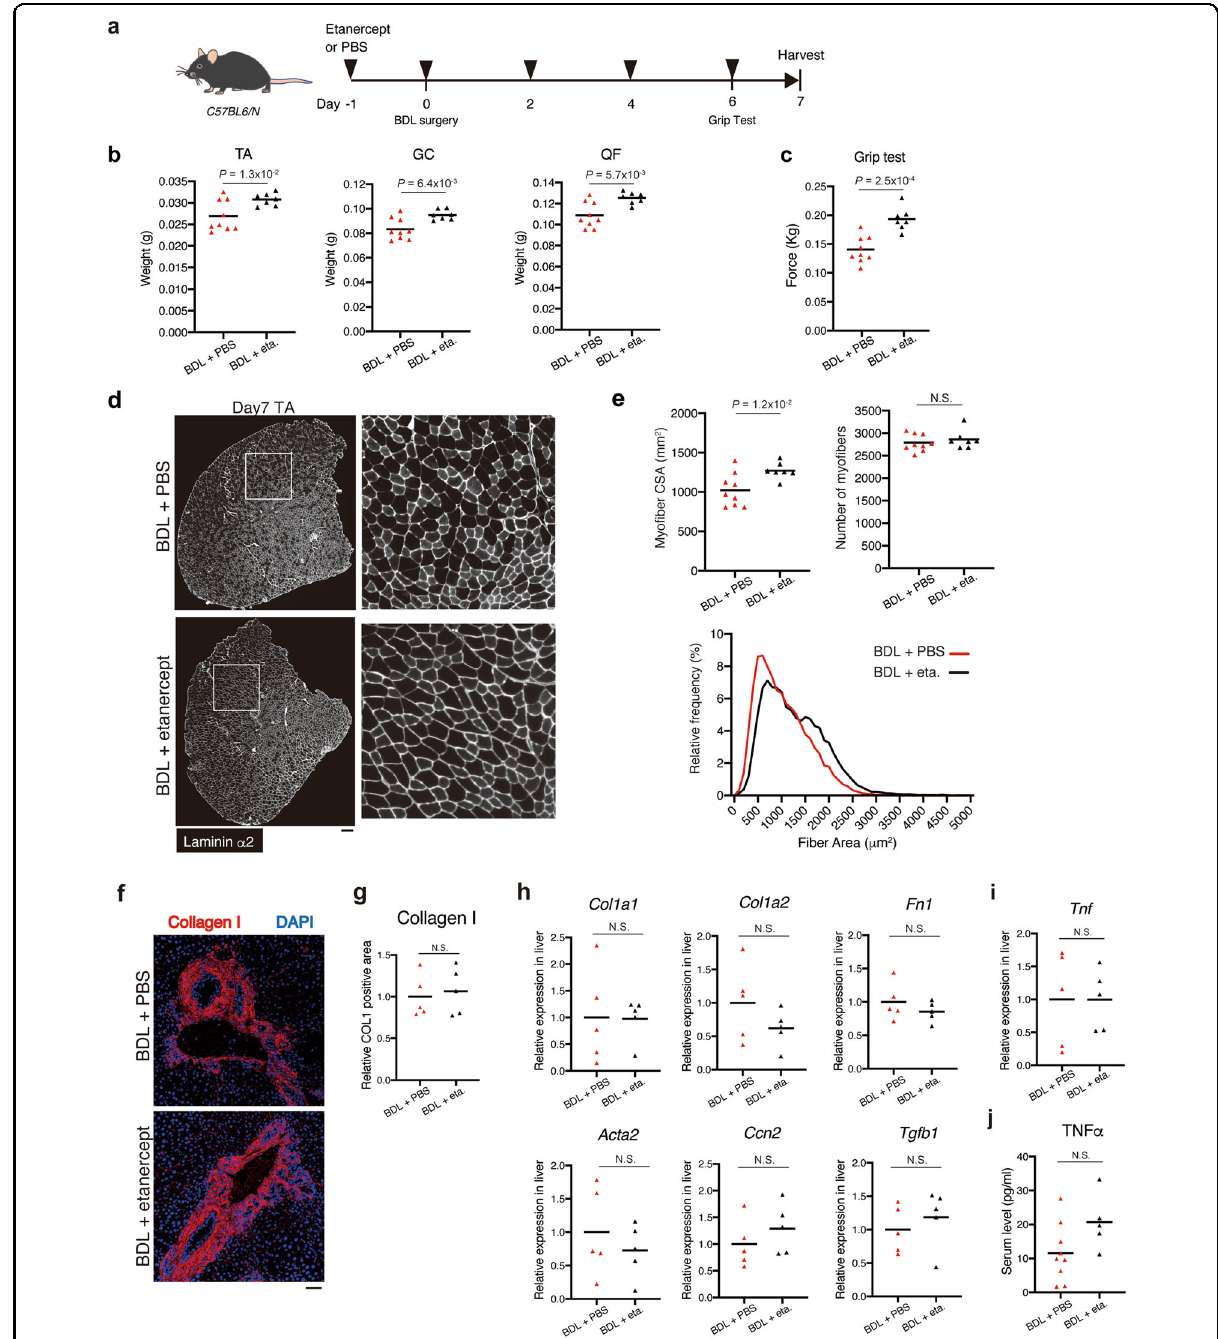
Fig. 6 TNF α inhibition alleviates BDL-induced muscle atrophy. a Experimental design of TNF α blockade by etanercept. b , c The muscle weight ( b ) and grip strength ( c ) of the BDL mice treated with PBS or etanercept was measured at day 7. d TA cross sections of the BDL mice treated with PBS or etanercept were stained for laminin α 2 at day 7 post-operation. Right panels show magni fi ed views of the boxed regions on left panels. e Myo fi ber CSA and the number of myo fi bers in TA of BDL mice treated with PBS or etanercept were quanti fi ed (upper). Myo fi ber CSA distribution in TA muscle is shown as a histogram (lower). f Liver sections of BDL mice treated with PBS or etanercept were subjected to immuno fl uorescence staining for collagen I and DAPI at day 7 post-operation. g The collagen I-positive area was quanti fi ed. h The hepatic expression levels of fi brosis-related genes ( Col1a1, Col1a2, Fn1, Acta2, Ccn2 , and Tgfb1 ) were quanti fi ed on day 7 post-operation of BDL mice treated with PBS or etanercept. i , j The expression level of Tnf in the liver ( i ) and the serum levels of TNF α ( j ) of the BDL mice treated with PBS or etanercept were measured at day 7 post-operation. n = 9 mice for PBS group and n = 7 for etanercept group ( b , c , e ). n = 5 mice for each group ( g , h , i ). n = 9 mice for PBS group and n = 5 for etanercept group ( j ). Data were analysed using the two-sided unpaired t -test. Scale bar, 200 μ m ( d ) and 50 μ m ( f ).